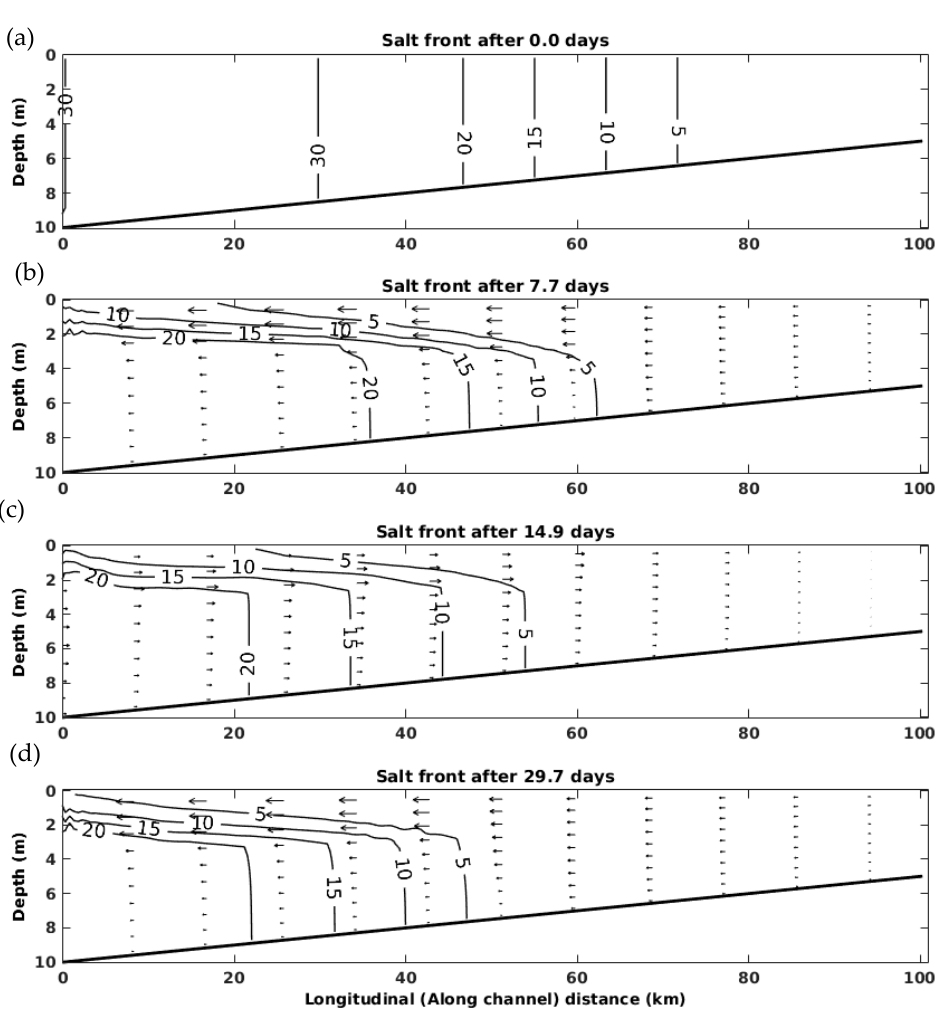
Figure 6. Case 4: Estuary test case with a rectangular geometry; Along channel estuarine flow with tidal input from west and river input from east at different time intervals (Simulation setup for 30 days using MPDATA). Arrows represent scaled velocity vector with a scaling factor of 2.5.